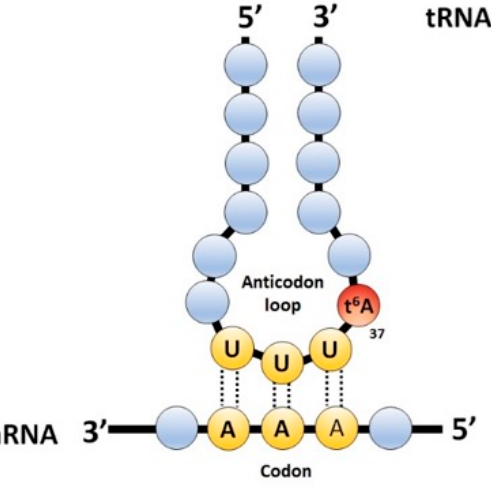
Figure 1. N 6 -threonylcarbamoyladenosine (t 6 A) is harbored in position 37 of A-starting codons (ANN)-pairing transfer RNAs (tRNAs). The schematic representation of the anticodon loop of an ANN-pairing tRNA: t 6 A at position 37 is represented as a red full circle; the anticodon is represented in yellow; and the rest of the tRNA in light blue. Messenger RNA (mRNA) is represented at the bottom in light blue circles and the codon in yellow. Codon-anticodon interactions are depicted with dotted lines, and are stabilized by t 6 A, thus preventing intra-loop bonding between positions U33 and A37.